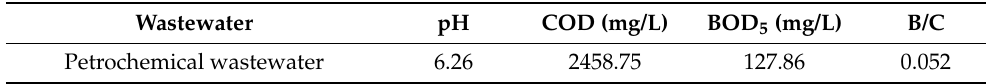
Table 1. Petrochemical wastewater quality indicators.